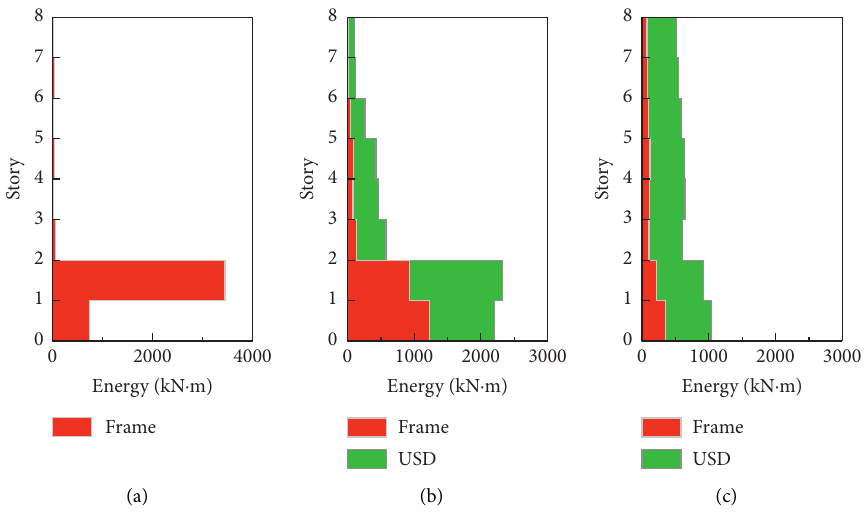
Figure 15: Energy dissipation at different storeys under GM9.